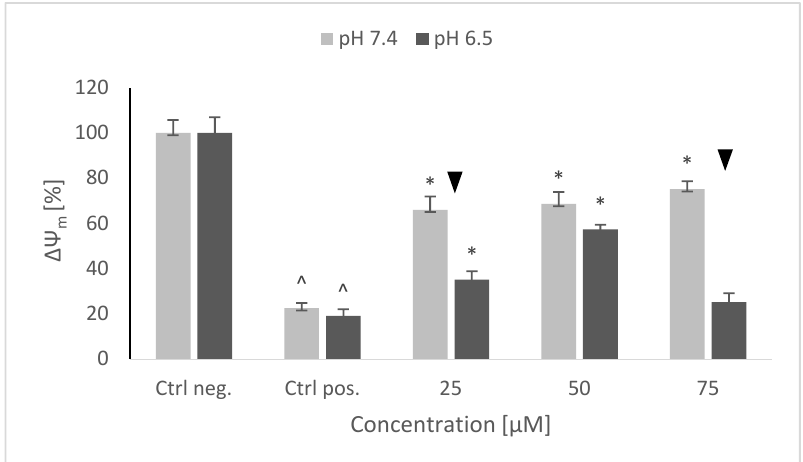
Figure 7. Changes in the mitochondrial potential of SH-SY5Y cells after pretreatment with NRNPs pH and exposure to 6-hydroxydopamine. The whiskers are standard deviation. ^ p ≤ 0.05, Student t -test vs. the negative control (Ctrl neg.; cells not treated with 6-OHDA), ▼ p ≤ 0.05, paired sample Student t -test, differences between the different pH conditions (pH 7.4 vs. pH 6.5), * p ≤ 0.05, Student t -test vs. the positive control (Ctrl pos.; cells treated with 6-OHDA only, without any pretreatment); n =